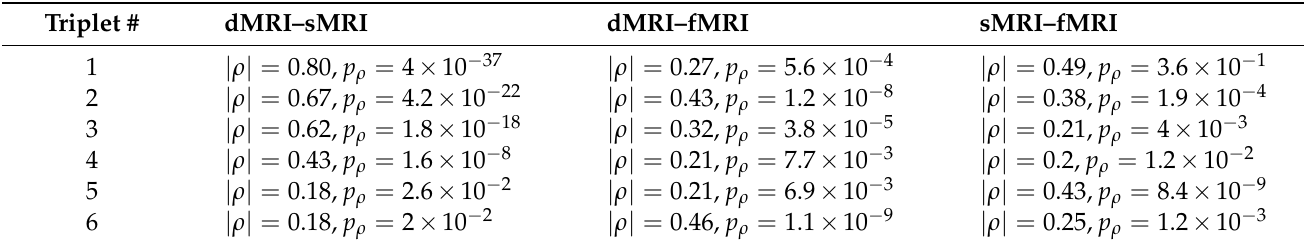
Table 1. The absolute values of the pair-wise Pearson correlation coefficients the values of p ρ